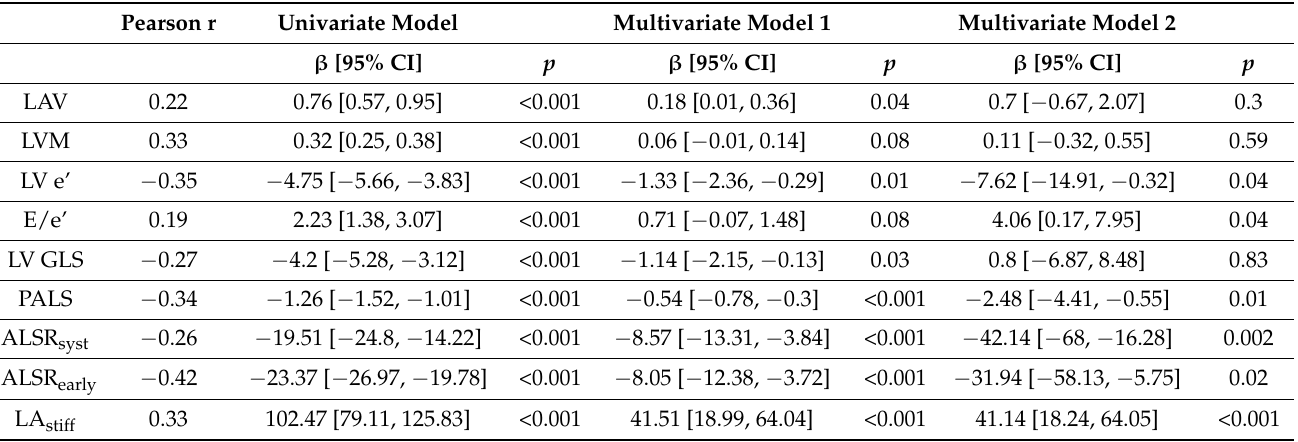
Table 3. Multiple linear regression analysis for association of EFV with diastolic function and deformation